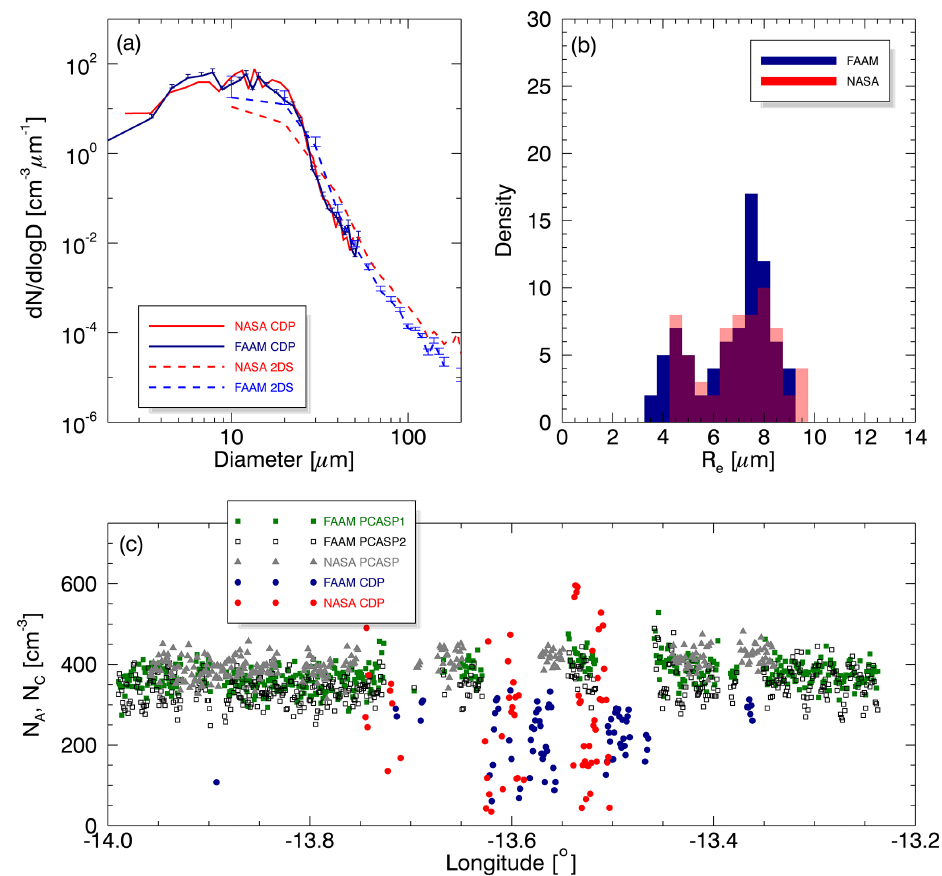
Figure 11. (a) Cloud PSD, (b) PDF of cloud particle R e , and (c) time series of N c (CDP) and interstitial N A (PCASP) at cloud level. Errors in PSD as Fig. 7 are shown only for FAAM platform to aid